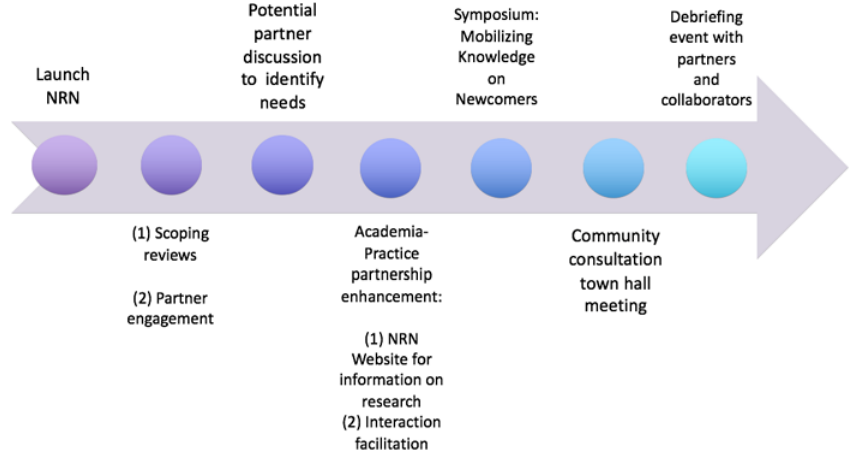
Figure 1 Process of connecting beyond the Newcomer Research